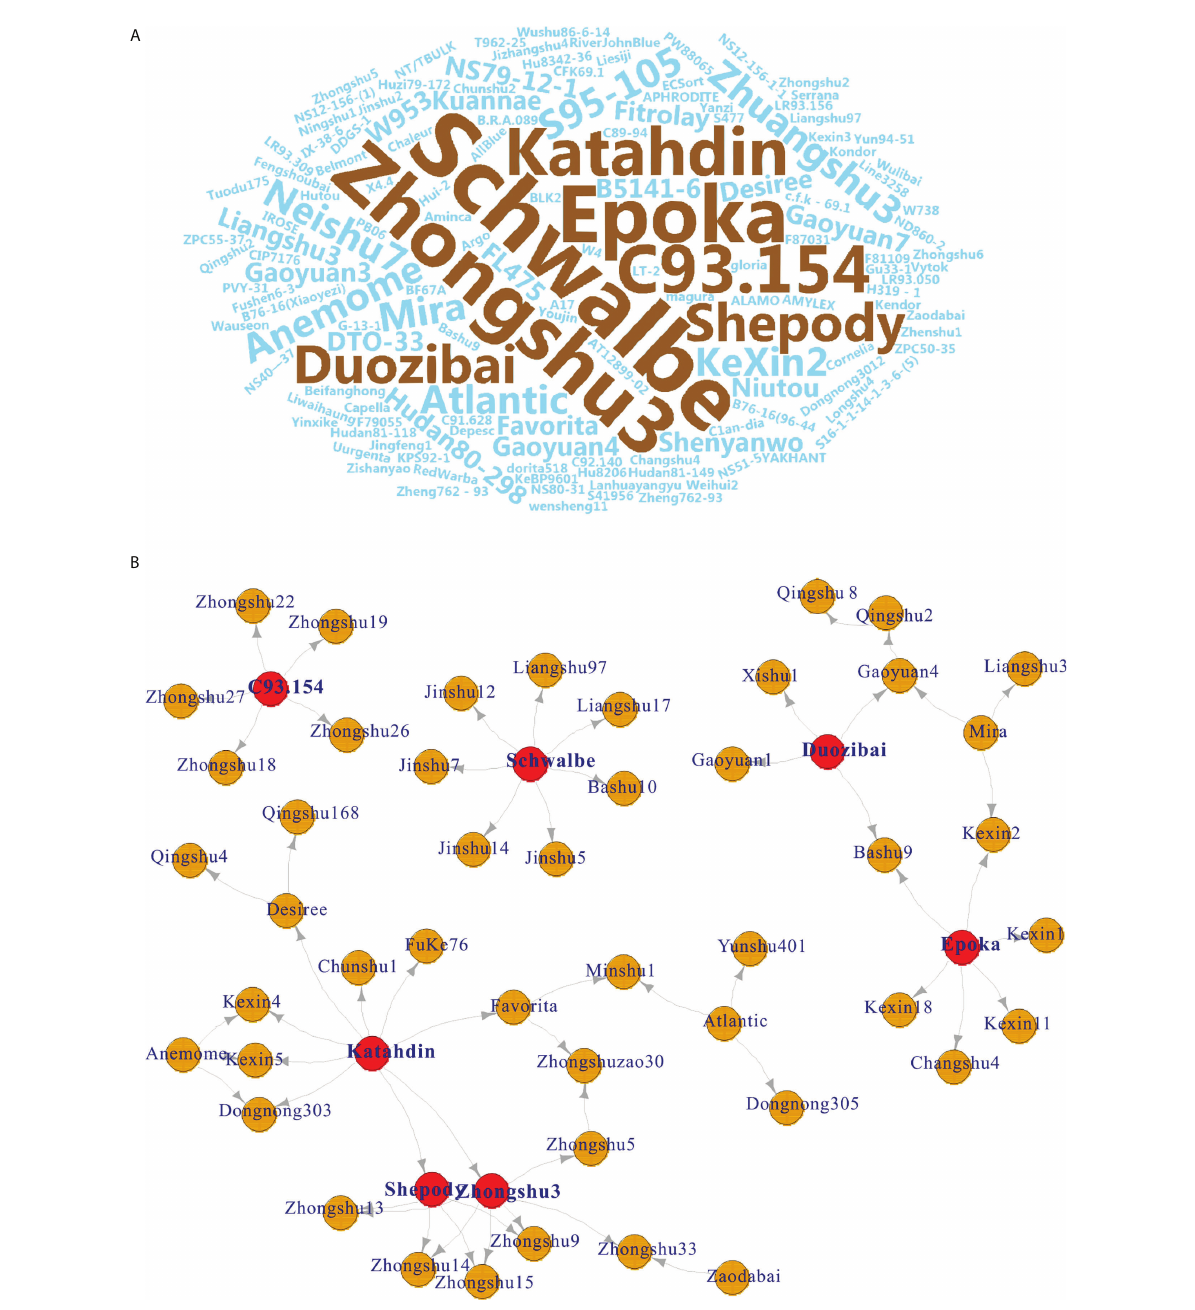
FIGURE 2 Pedigree-based word cloud and network analysis. (A) Pedigree-based word cloud analysis of 149 potato varieties; the most frequently used parents are shown in brown. (B) Network of seven high-frequency potato varieties (red node) based on the results of the word